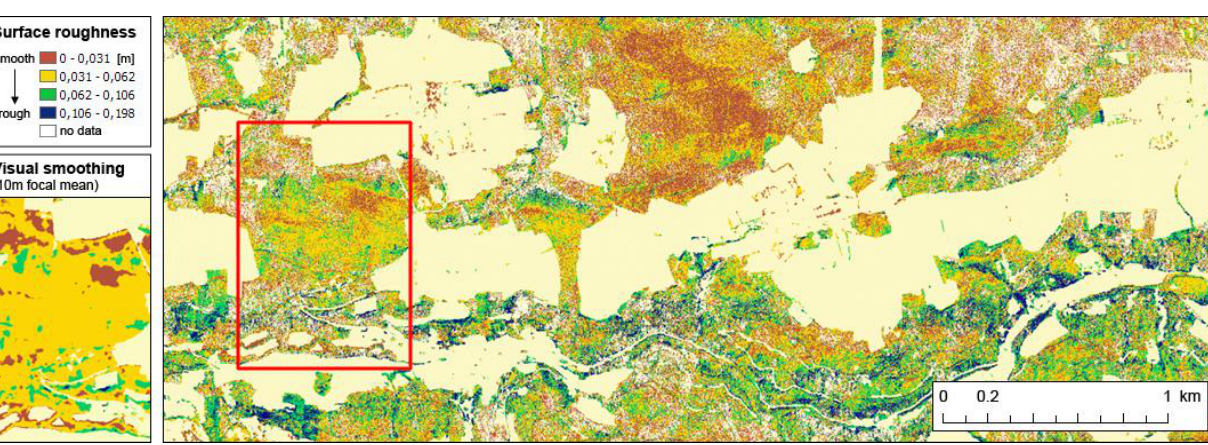
Figure 5. Surface roughness raster layer (1.0 m resolution) for the test site Bucklige Welt , classified in four roughness categories from smooth (red) to rough (blue). Non-wooded areas are masked out (in light yellow). Detail: Smoothed visual impression through applying a focal mean